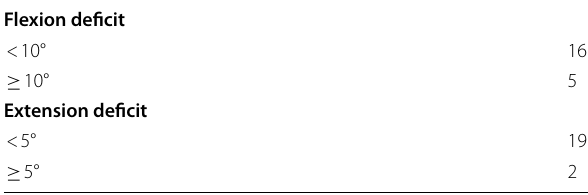
Table 4 The range of motion at follow-up in